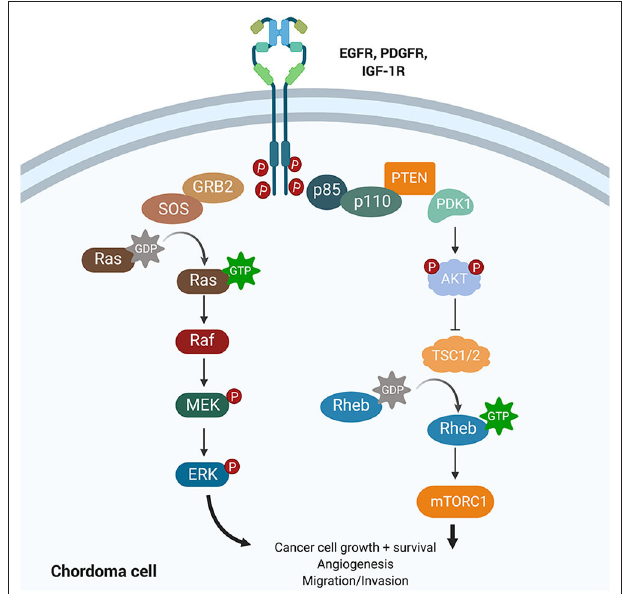
FIGURE 5 | Growth factor signaling pathways implicated in chordoma pathogenesis. The PI3K/AKT and the RAS pathways lie downstream of EGFR, PDGFR, and IGF-1R and have been implicated in cancer promotion and progression. Upregulation of PI3K/AKT was associated with high brachyury expression in chordomas and may also regulate tuberous sclerosis comorbidity with chordomas. IGF-1R is a novel target whose activation was associated with poorer prognosis and increased tumor volume in